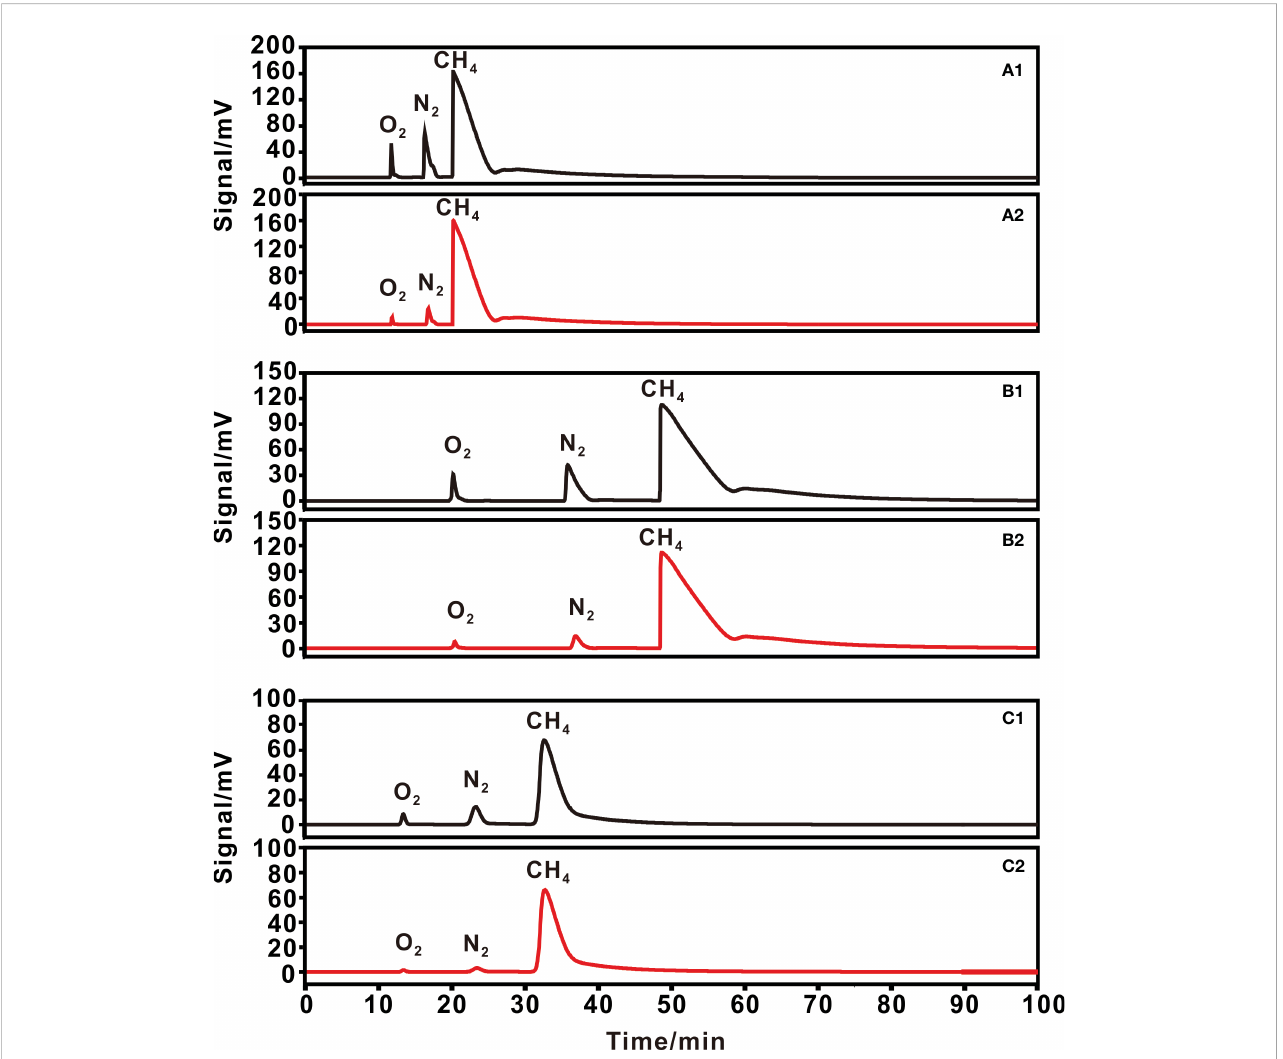
FIGURE 4 Chromatograms of 90% methane +10% air, for (1) initial gas and (2) puri fi ed gas on (A) 3,2,1/8 columns; (B) 6,2,1/8 columns and (C) 3,1.5,1/4 columns.